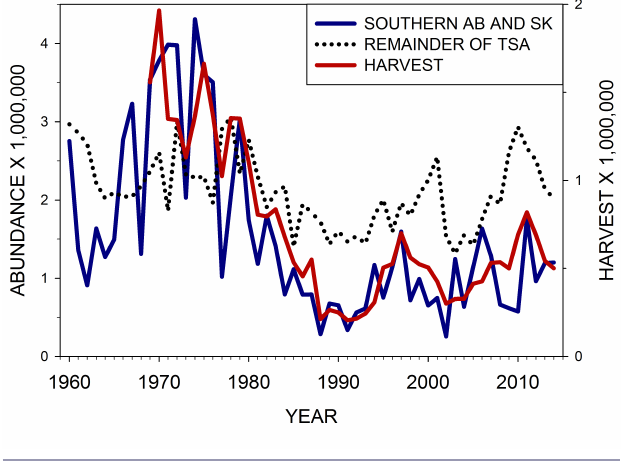
Fig. 1. Population abundance of Northern Pintail ( Anas acuta ) in the Traditional Survey Area (TSA) of the Waterfowl Breeding Population and Habitat Survey in North America (left axis). Also shown are annual harvest estimates of Northern Pintail derived from the Canadian and U.S. national harvest surveys (right axis). “Southern AB and SK” includes